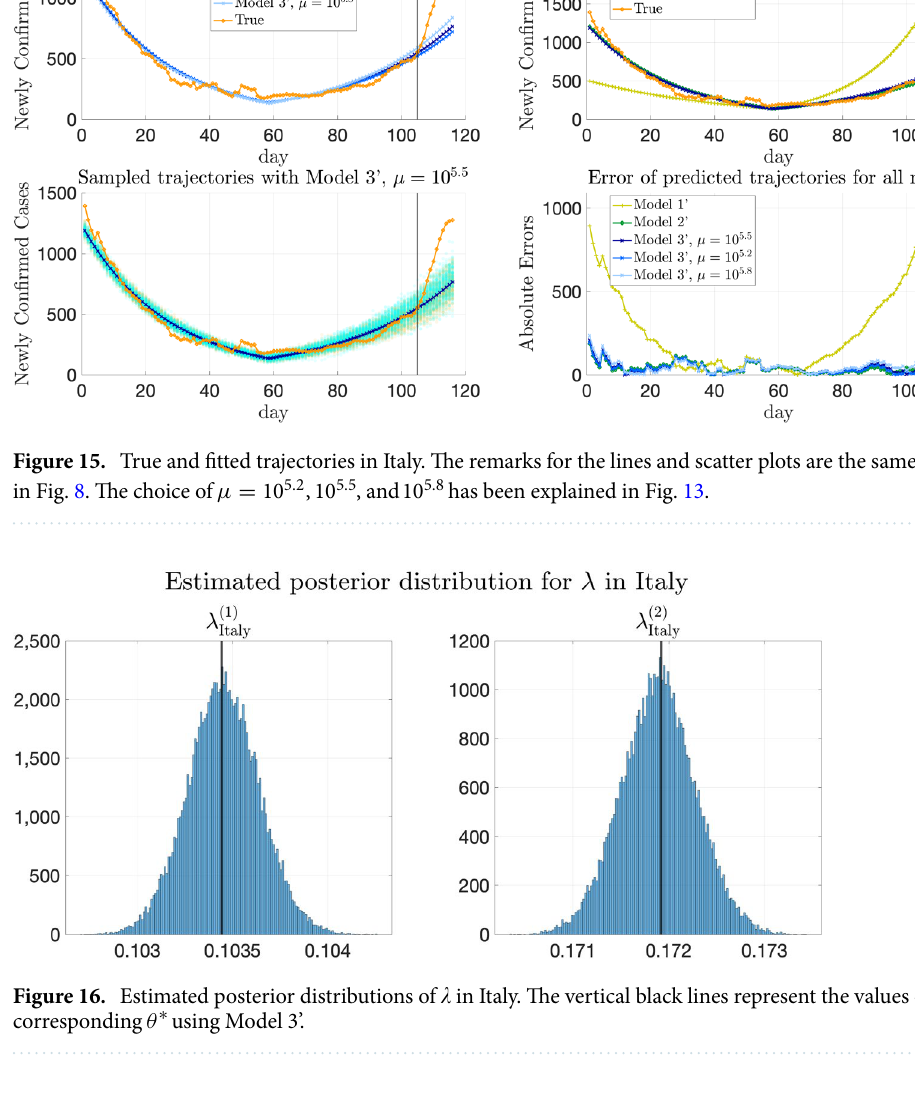
Mean of estimated posterior Standard deviation of estimated posterior